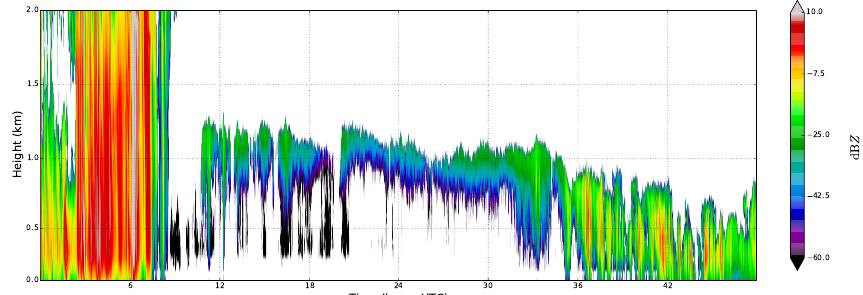
Figure 2. Radar backscatter cross section over the 2-day period used in the